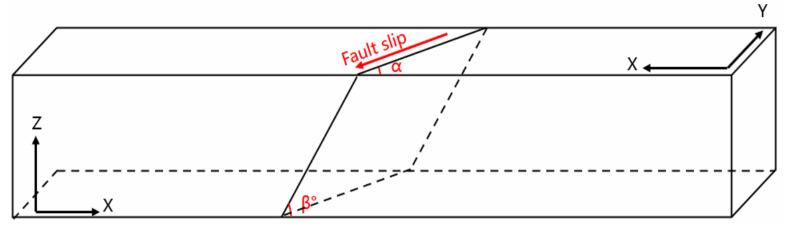
Figure 11. Schematic diagram of fault slip.